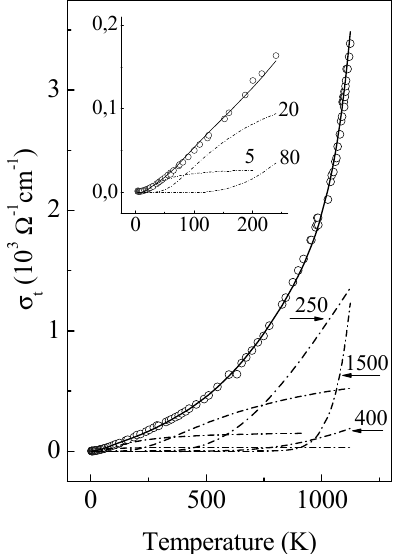
Figure 9. Temperature-dependent part of the dc conductivity of the ordered Al 63 Cu 25 Fe 12 phase: (o), experimental results [2]; and solid line, description of the results by a sum of the conduction elementary terms (dash-dotted lines) with δ E = 5, 16, 80, 260, 400, and 1500 meV,